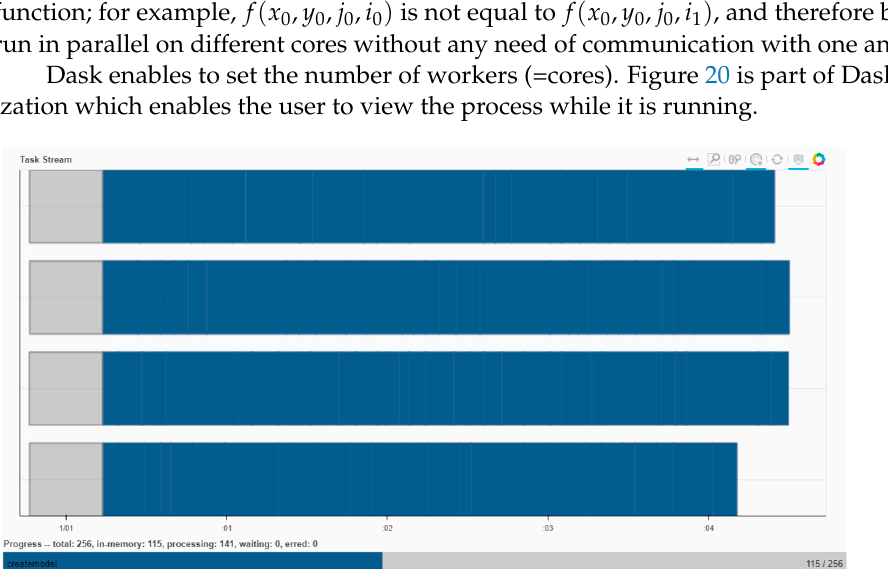
Figure 21. Visualization for execution time in minutes.